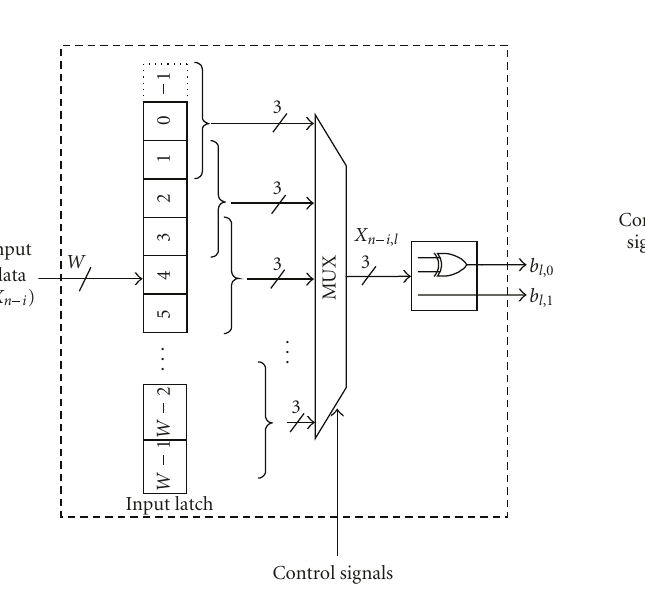
Figure 3: The proposed FIR architecture with input-data and tap folding.